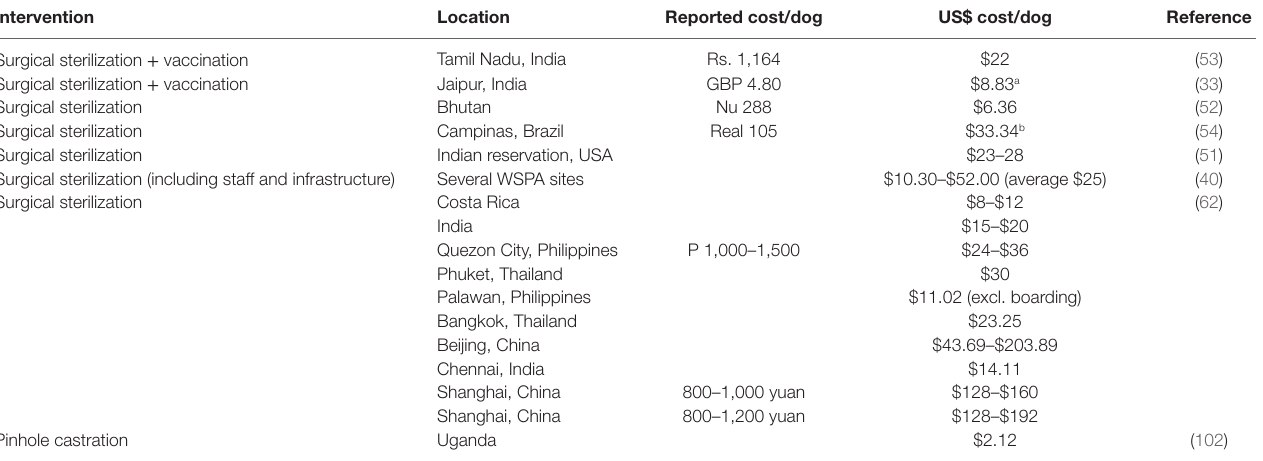
TABLe 4 | Published data on sterilization costs for high throughput programs.